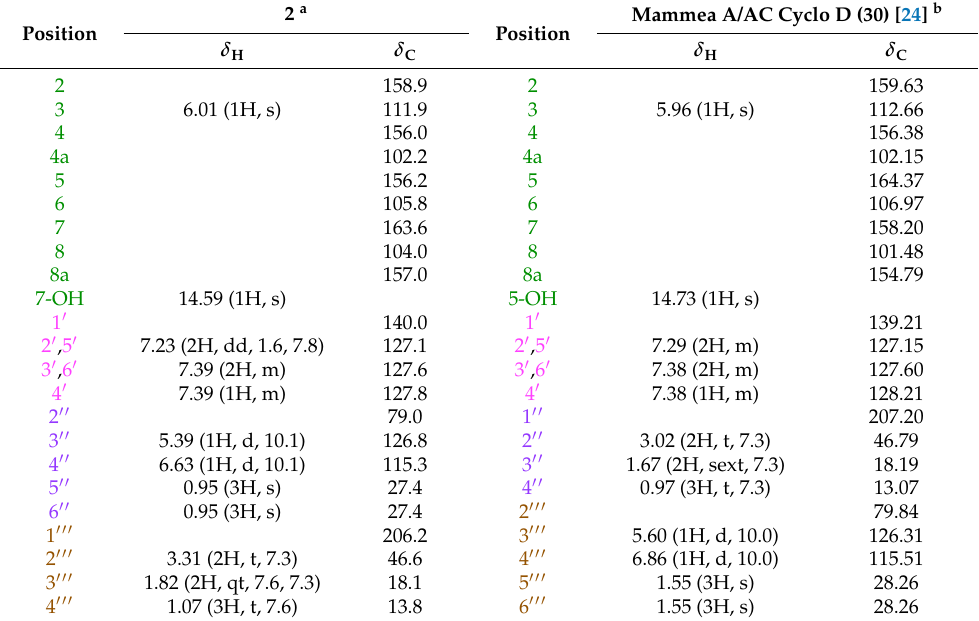
Table 2. 1 H and 13 C NMR spectroscopic data (CDCl 3 ) of mammeasins L ( 2 ) and mammea A/AC cyclo D ( 30